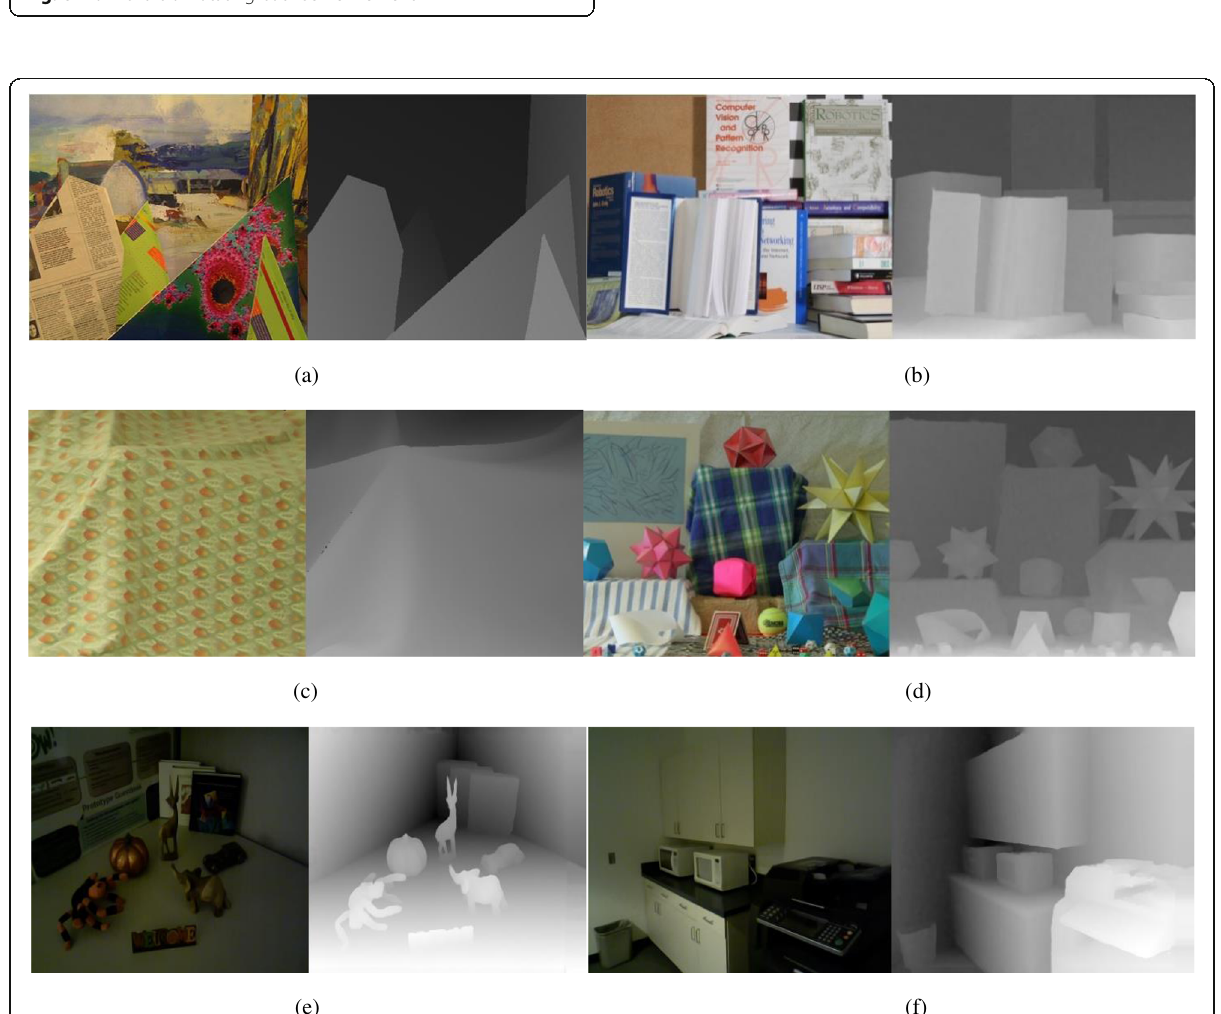
Fig. 4 Four test images ( left ) and their corresponding depth maps ( right ): a Arts (432 × 381), b Books (463 × 370), c Doily (417 × 370), d Moebius (463 × 370), e RGBD_1 (640 × 480), and f RGBD_2 (640 ×